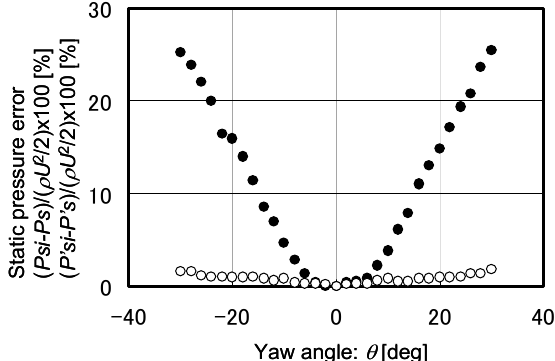
Fig. 8 Yaw angle Characteristics on mean static pressure ( ● ) and fluctuation static pressure ( ○